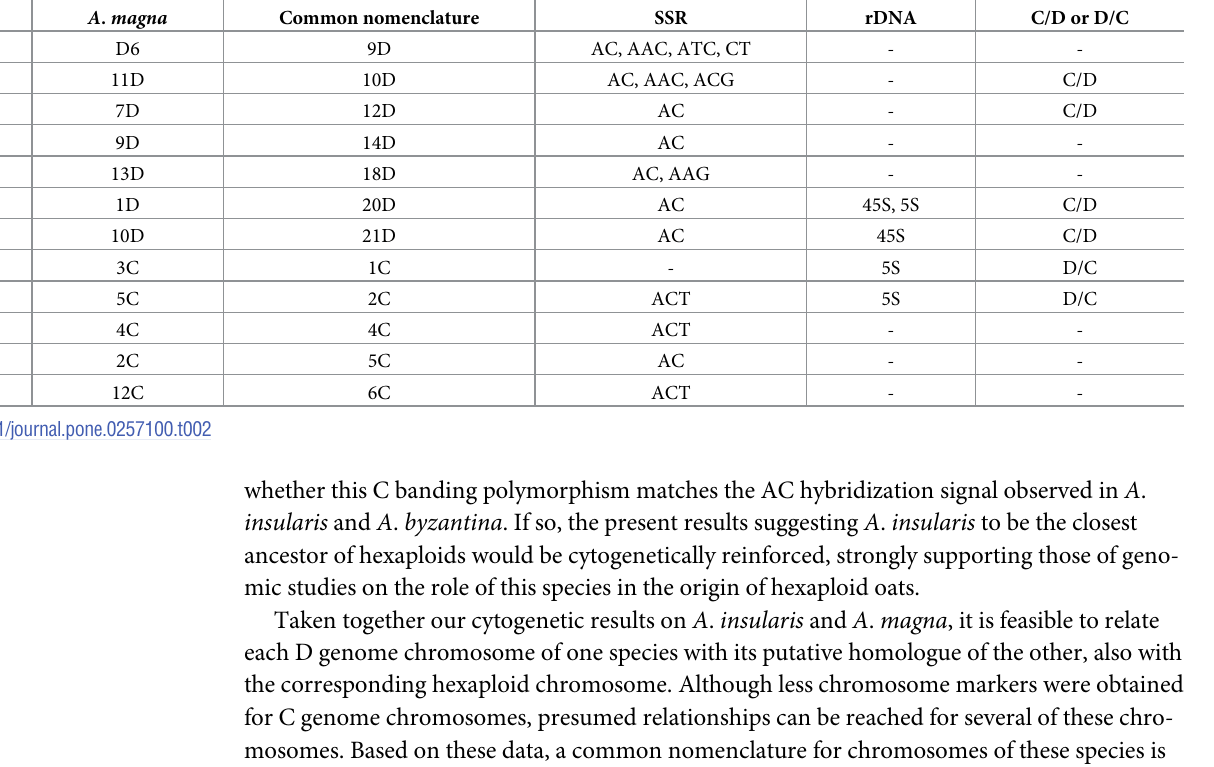
S1 Table. Occurrence and main distribution of SSRs in CCDD tetraploids: A . insularis , A . magna and A . murphyi and AACCDD hexaploids: A . byzantina and A . sativa . (DOCX)